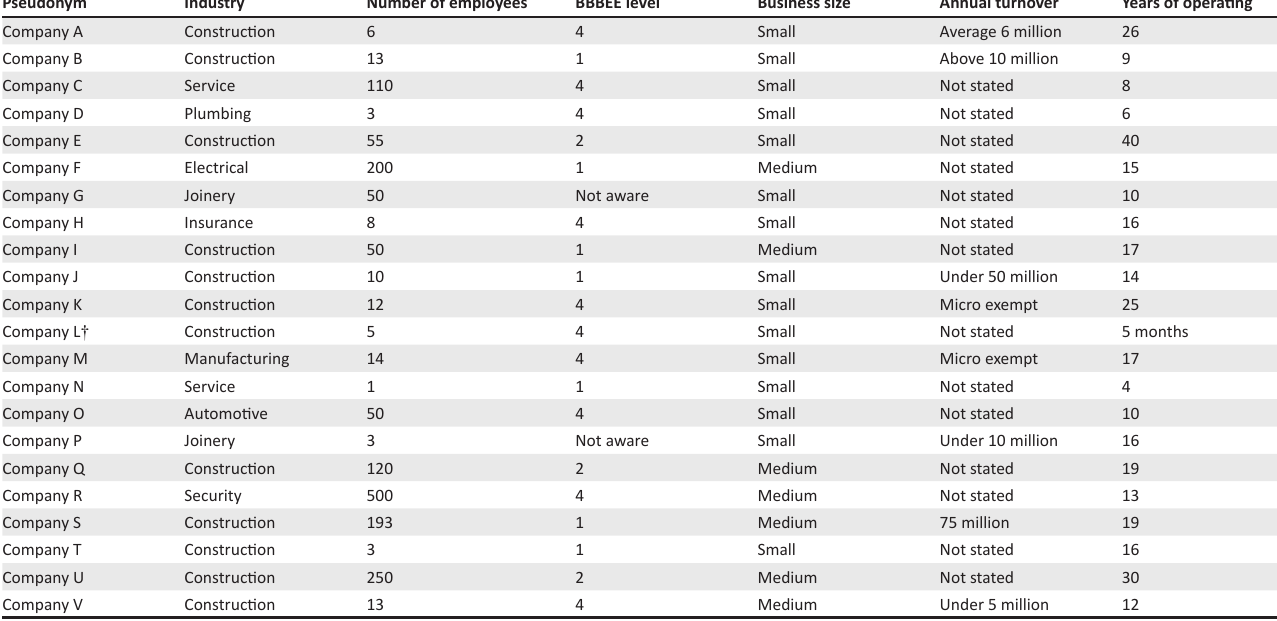
TABLE 1: Participants of the study.